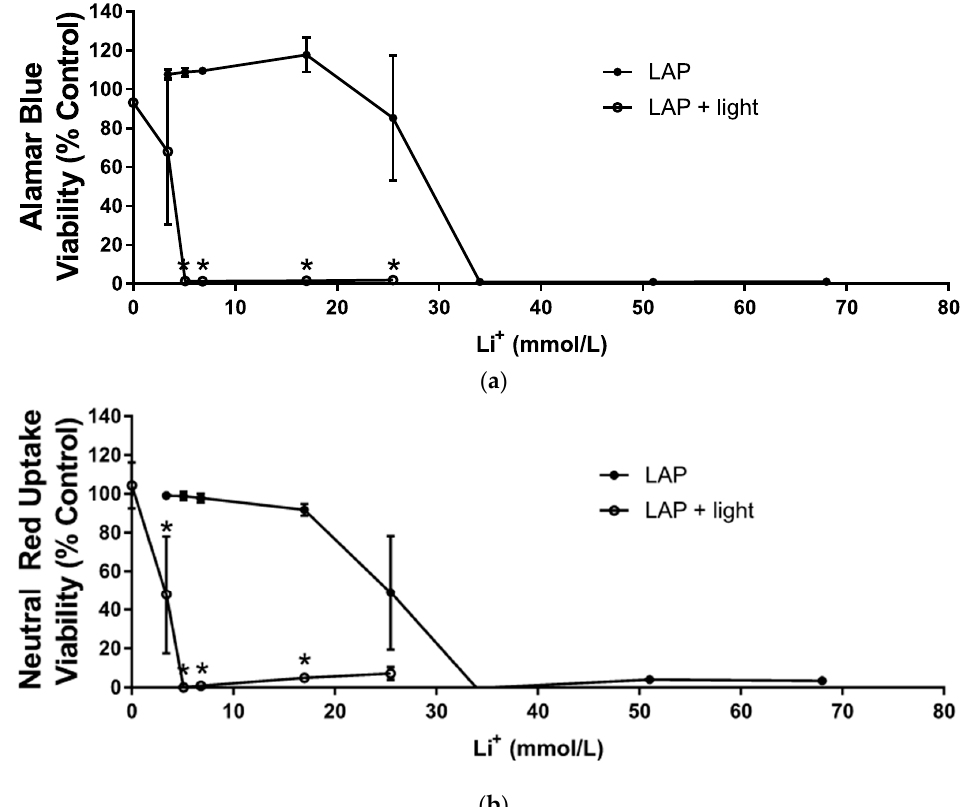
Figure 2. Viability of mouse M-1 collecting duct cell monolayers exposed to varying concentrations of LAP (3.4, 5.1, 6.8, 17, 25.5, 34, or 68 mmol/L) and not-exposed (•) or exposed to 9.6 mW/cm 2 405 nm light ( o ). LAP concentrations are represented as equivalent Li concentrations. Results are normalized to the viability of monolayers exposed only to PBS and not exposed to light. CdCl 2 (1 mmol/L) was used as the positive control; viability averaged 0% for both assays (data not shown). ( a ) Viability determined by the Alamar Blue assay. ( b ) Viability determined by the Neutral Red Uptake assay. Values represent means ± standard deviations of N = 3 independent replicate experiments. Values that appear to be missing error bars are cases where the standard deviation is smaller than the symbol size. Asterisks (*) denote treatments where the viability of monolayers exposed to LAP is significantly different ( p < 0.05) from the viability of monolayers exposed to LAP and light.